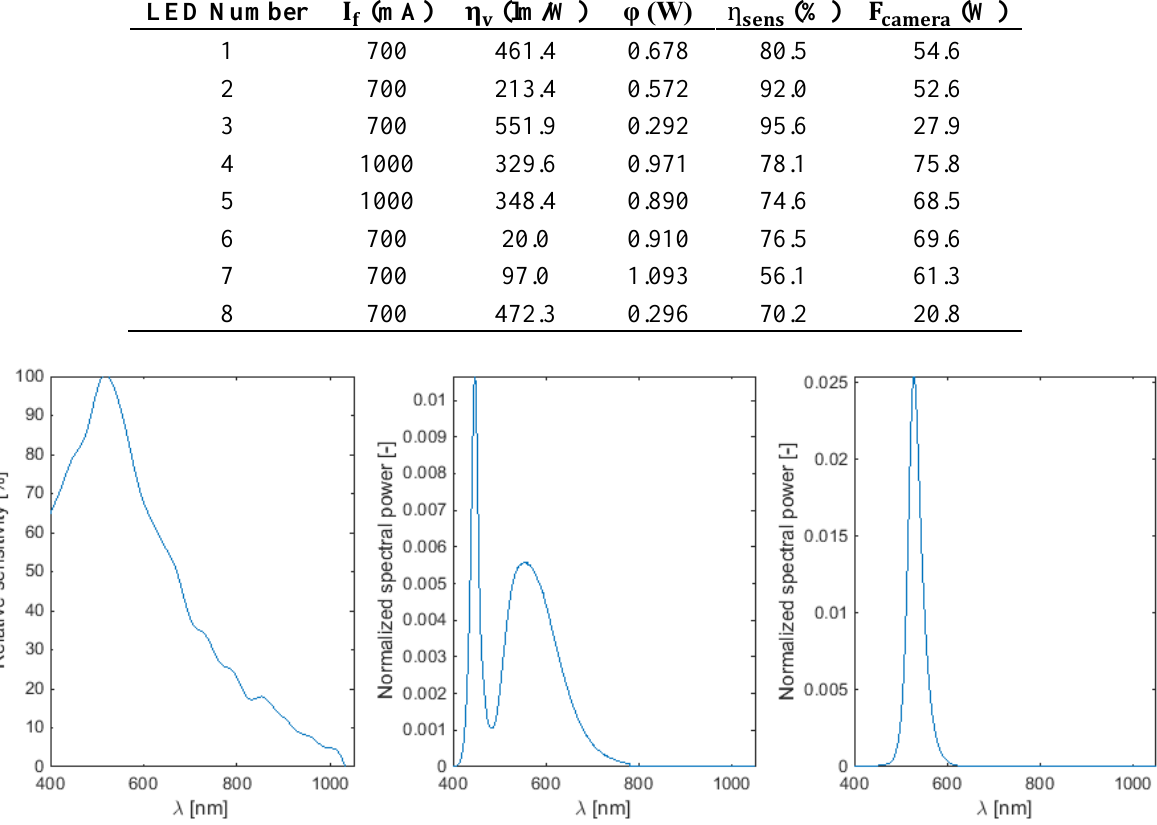
Figure 4. ( Left ): Relative camera sensitivity; ( Middle ): Normalized spectral power distribution for LED 4; ( Right ): Normalized spectral power distribution for LED